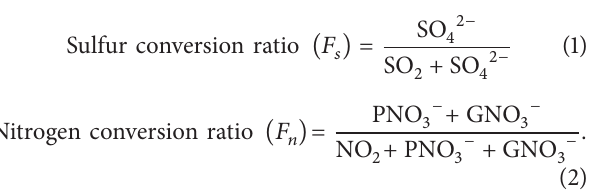
36%; southeast (SE): 59%; and east (E): 5%. Similarly, the corresponding values for the haze period were S: